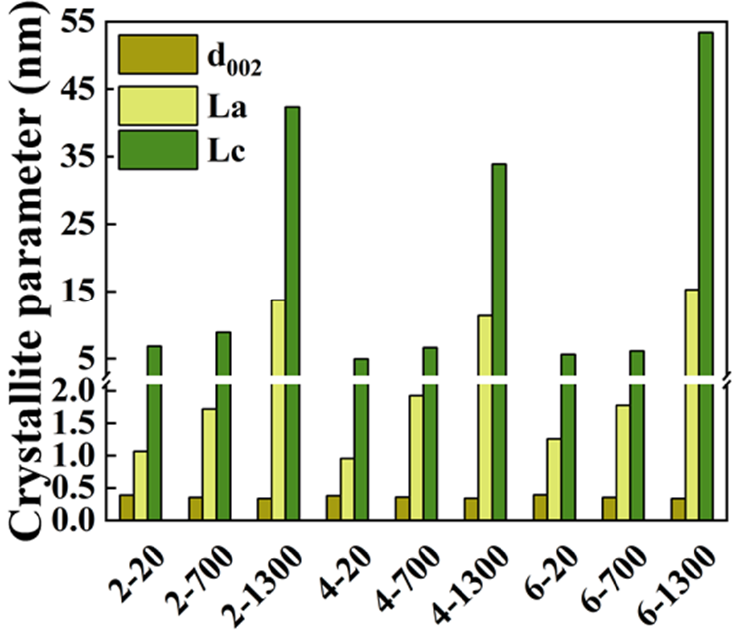
Figure 2. Variation diagram of XRD microcrystalline structure parameters.